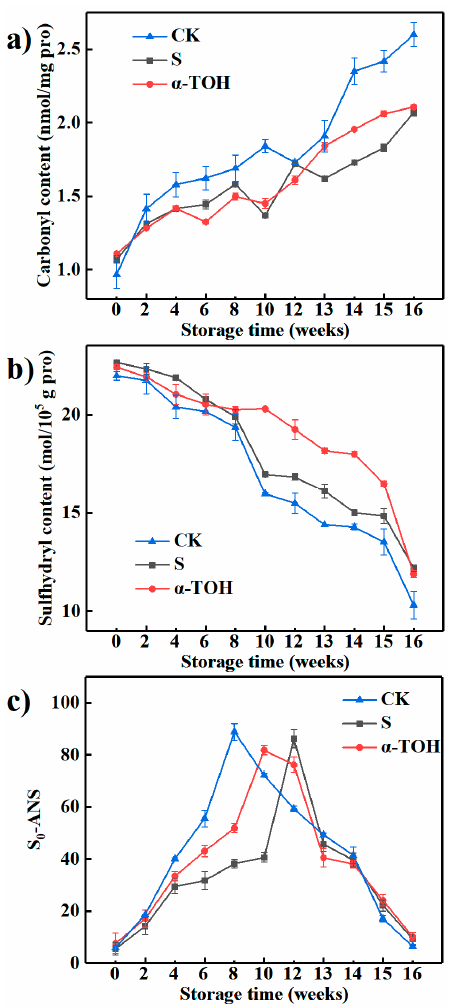
Figure 4. Effects of α -TOH on the carbonyl content ( a ), total sulfhydryl content ( b ) and surface hydrophobicity ( c ) of sturgeon surimi during 16-week frozen storage at − 18 °C. Bars represent the standard deviation from triplicate determinations ( n = 3; 3 means 3 replicates).